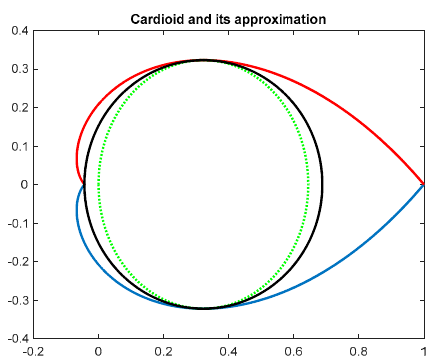
4 of 15 Figure 1. Stable system pole regions. ( a ) Continuous-time system: Open left half plain of the convex plane; ( b ) discrete-time systems: Interior of the unit circle. Figure 2. Pole regions for the prescribed stability degree (corresponding to the system exponential decay rate). ( a ) Continuous-time system: Shifted left half plain of the convex plane; ( b ) discrete-time systems: Interior of the “shrinked” unit circle – circle centered in [0,0] with radius 1/sqrt( α ), where α > 1. 𝑅 (cid:2869)(cid:2869) = 𝑅 (cid:2870)(cid:2870) = (cid:4674)0 0 0 0(cid:4675), 𝑅 (cid:2869)(cid:2870) = (cid:3428) 𝑠𝑖𝑛𝜑 𝑐𝑜𝑠𝜑 −𝑐𝑜𝑠𝜑 𝑠𝑖𝑛𝜑(cid:3432) Figure 3. Pole regions for the prescribed relative damping (corresponding to a ratio of the imaginary and real part of the pole). ( a ) Continuous-time system: Interior of the convex cone with vertex angle corresponding to the damping); ( b ) discrete-time systems: The space between two symmetric logarithmic spirals.